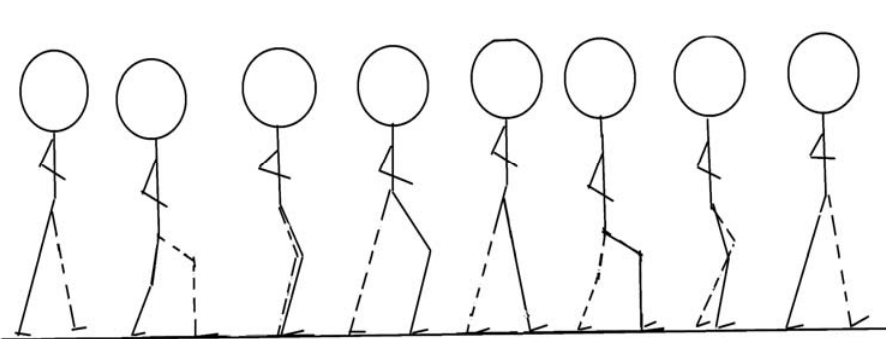
Figure 7. Walking action decomposition.